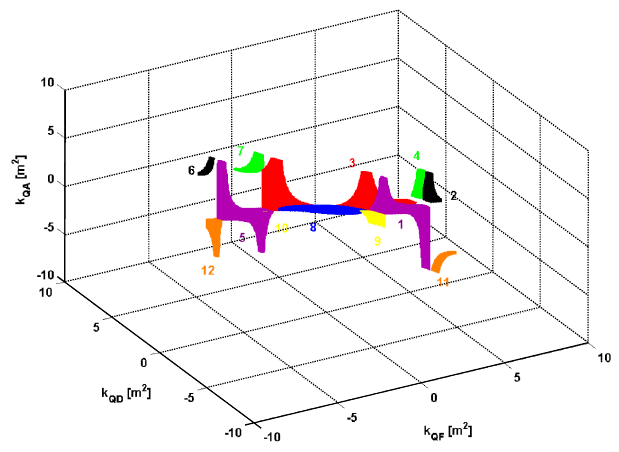
FIG. 13. (Color) The color mapping scheme in Fig. 12 is mapped into k -space.